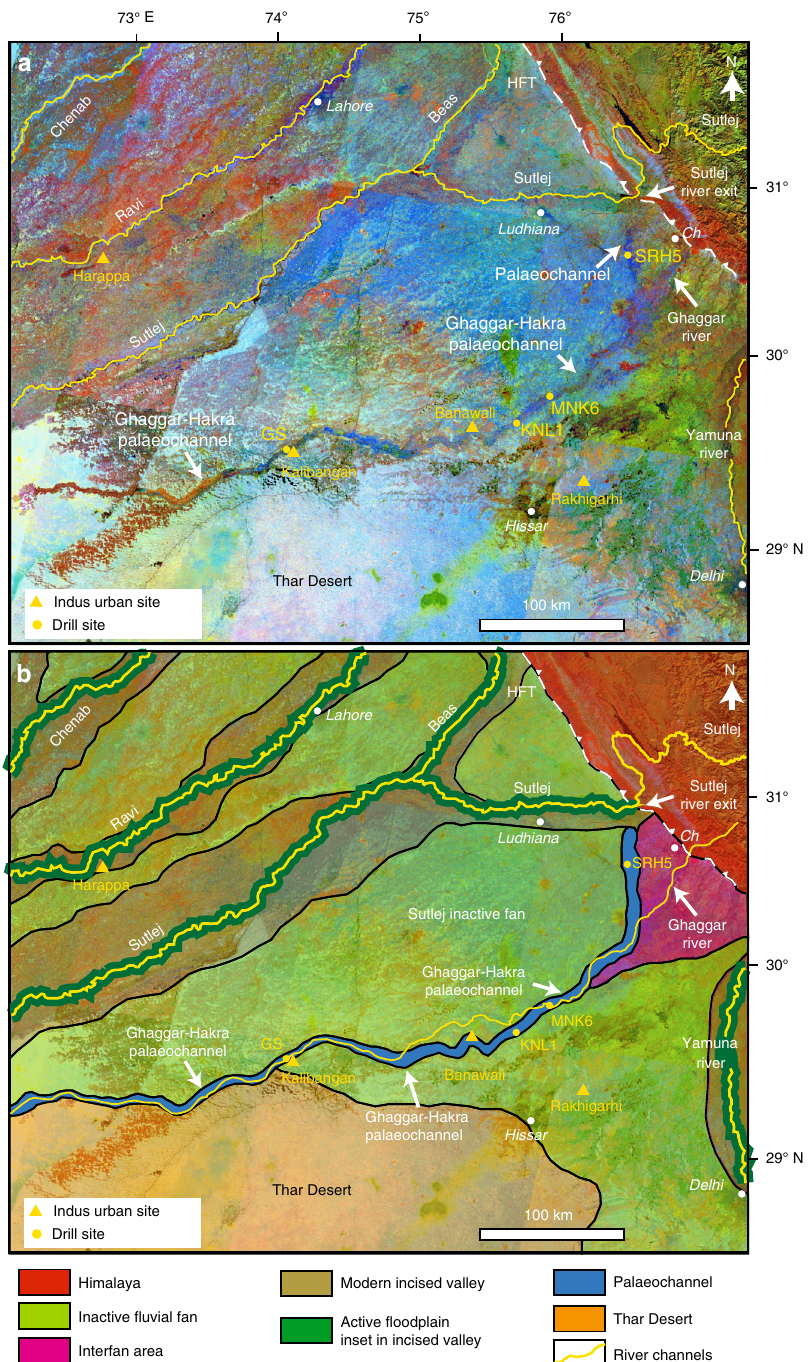
Fig. 2 Trace of Ghaggar – Hakra palaeochannel on northwestern Indo – Gangetic plain. a Background shows Landsat 5 TM colour composite mosaic (bands 456). The Ghaggar – Hakra palaeochannel is visible as a sinuous, dark blue feature. Location of GS core sites adjacent to the Indus urban centre of Kalibangan, along with core sites at KNL1, MNK6, and SRH5, are also indicated. Location of key Indus urban settlements indicated by triangles. b Geomorphological map showing major alluvial landforms in the study region. Ch , Chandigarh; HFT Himalayan frontal